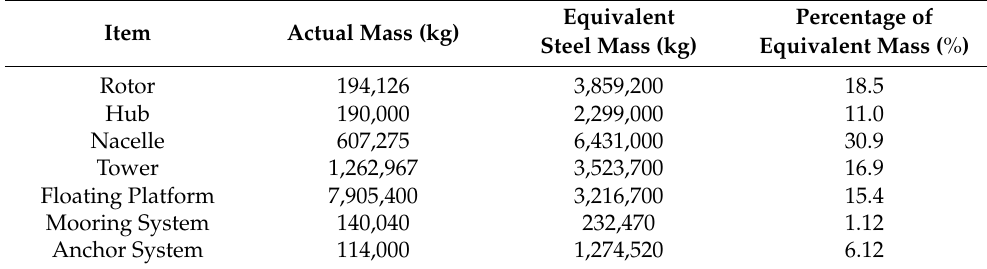
Table 13. Mass and equivalent masses of platform components.